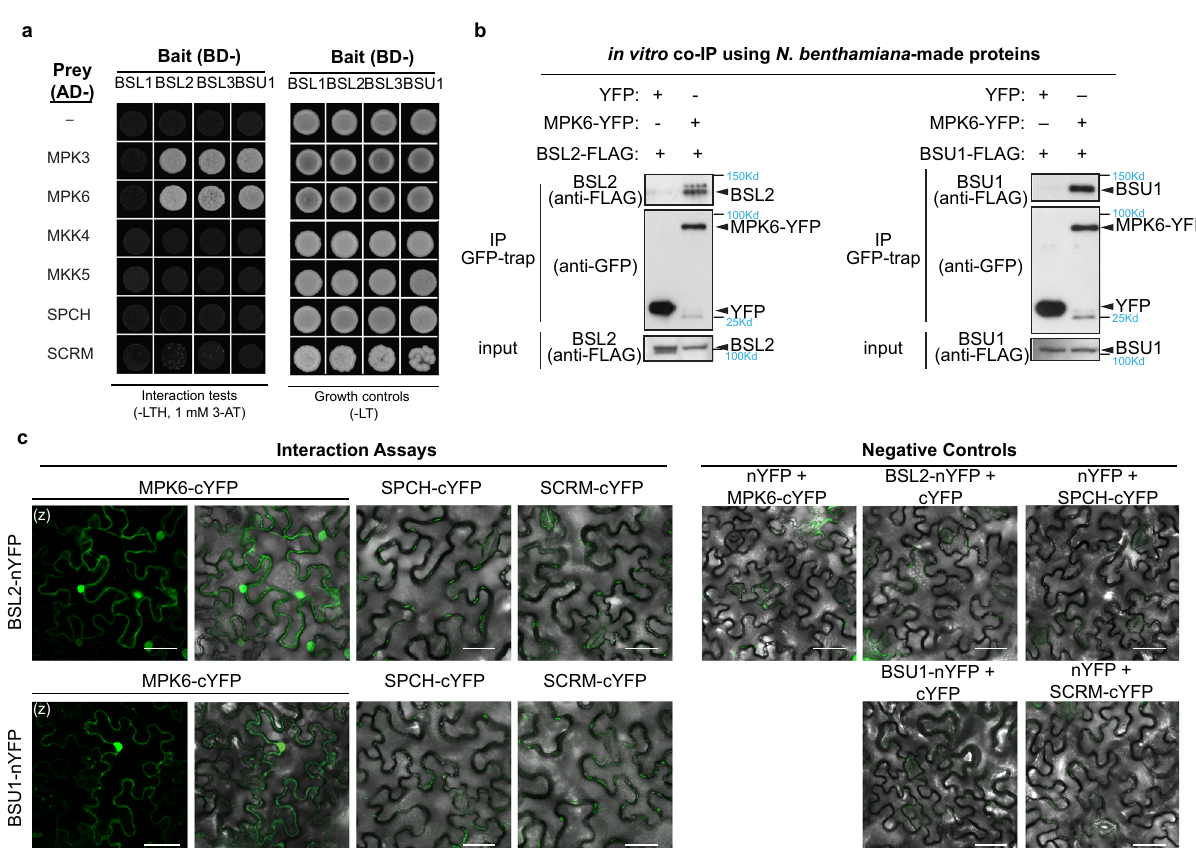
Fig. 5 BSL2/BSL3/BSU1 interact with MPK6. a Results of yeast two-hybrid assays show BSL2/BSL3/BSU1 proteins directly interact with MPK3/6. Bait, “ BD- ” indicates Gal4 DNA-binding domain; Prey, “ AD- ” indicates Gal4 activation domain. “ Growth controls ” , assays performed using rich media (-Leu- Trp); “ Interaction tests ” , assays performed using synthetic dropout medium (-Leu-Trp-His; 1 mM 3-AT added to suppress bait auto-activation). b Co-IP assays using puri fi ed fusion proteins produced by N. benthamiana leaves show physical association of BSL2-FLAG (left) or BSU1-FLAG (right) with MPK6- YFP. YFP (left lane, - control) or MPK6-YFP (right lane) was used as bait to bind to the GFP-Trap agarose. Immunoprecipitated proteins were detected by anti-FLAG. Data represent results of three biological repeats. c Results of bimolecular fl uorescence complementation (BiFC) assays in N. benthamiana leaf epidermal cells show BSL2 and BSU1 interact with MPK6 in plant cells. YFP signals (green) indicate protein-protein interactions. No interactions were detected between BSL2/BSU1 and the transcription factors SPCH/SCRM. nYFP, N-terminal YFP; cYFP, C-terminal YFP. Data represent results of three independent experiments. Scale, 50 μ m. (z), z-staked confocal MPK6 phosphorylation levels were gradually reduced (Fig. 6a). Importantly, the addition of a blend of phosphatase inhibitors (PhosSTOP) abolished the effect of BSL2 (Fig. 6a). Consistent results were obtained when we performed the in vitro kinase assays using myelin basic protein (MBP) as a substrate of MPK6 (Supplementary Fig. 8a). Thus, the results suggested that the kinase activity of MPK6 is inhibited by BSL2 in a dosage-dependent manner.